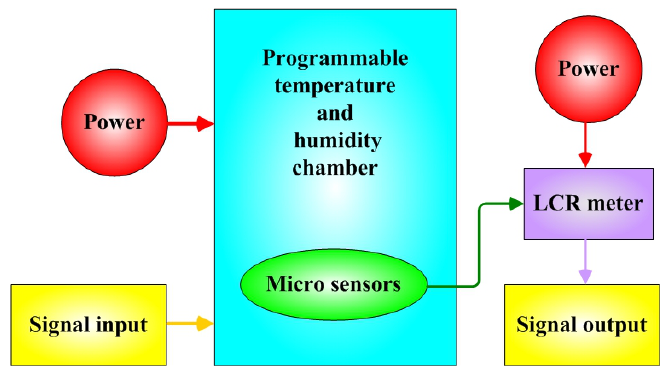
Figure 5. Calibration system of micro sensors.